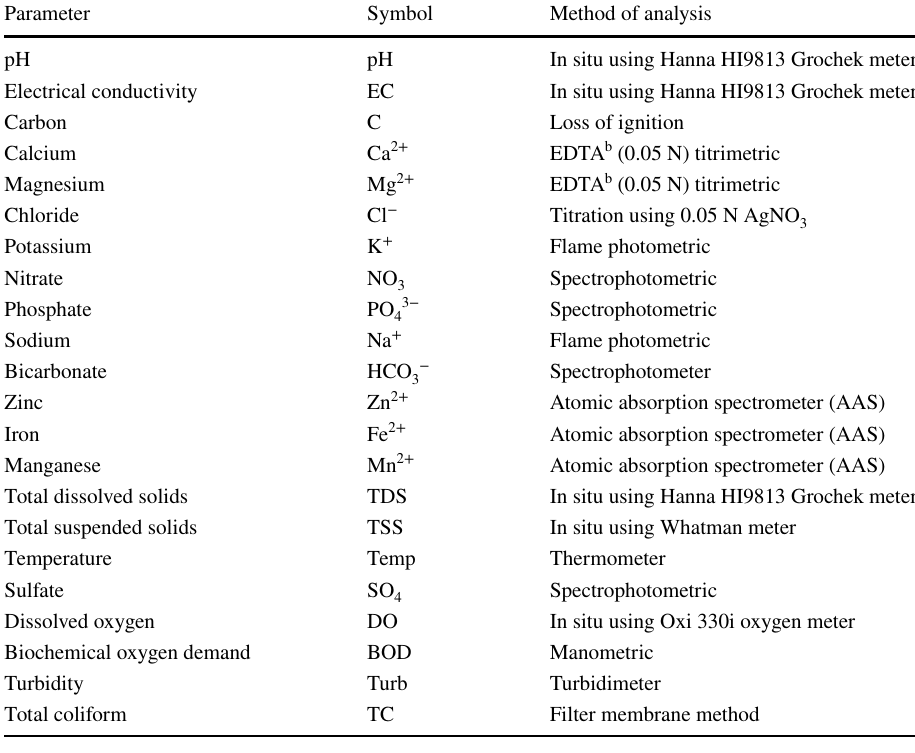
Table 2 Water quality analysis adopted methods